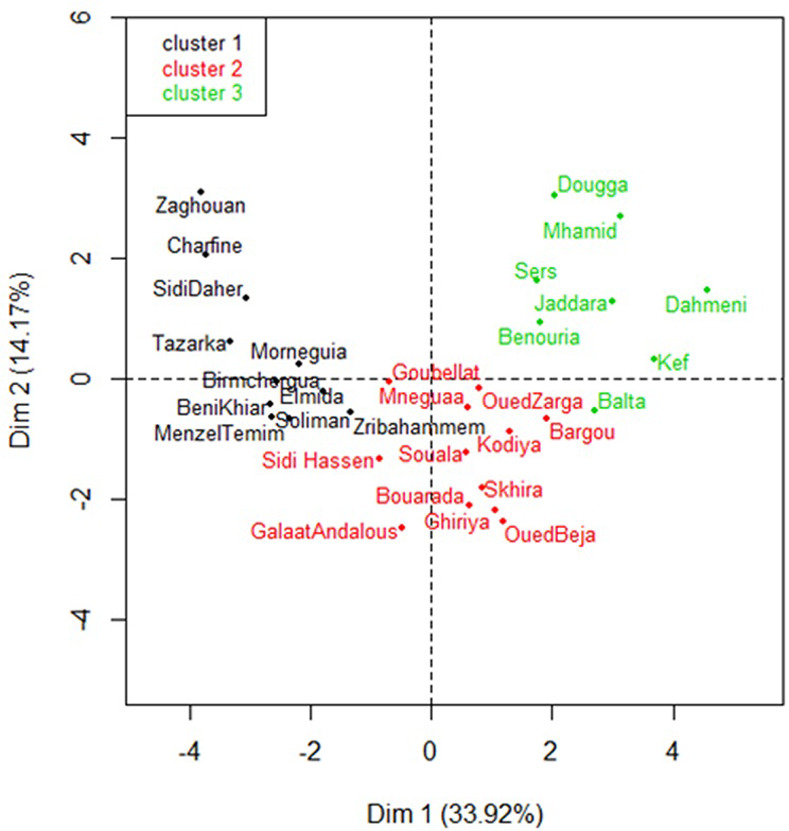
Hierarchical Ascendant Classification (HAC) on principal component analysis (PCA) of the studied sites.Dim.1 and Dim. 2 are the two first dimensions issued from the PCA.